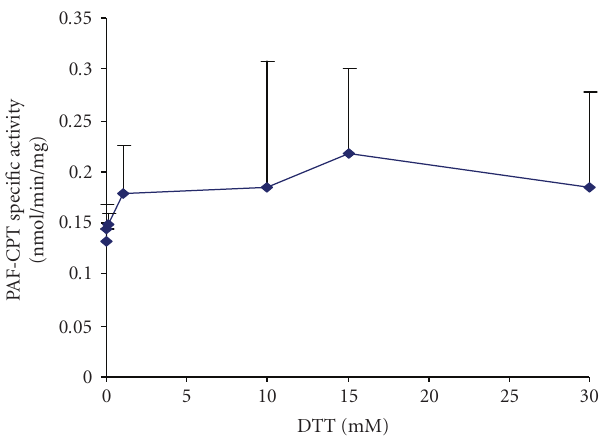
Figure 3: E ff ect of DTT concentration on PAF-CPT specific activ- ity of mesangial cells: microsomal fractions of HMC 0.05 mg/mL were incubated in the presence of di ff erent concentrations of DTT. Results are the average of two independent determinations using di ff erent enzyme preparations performing duplicate